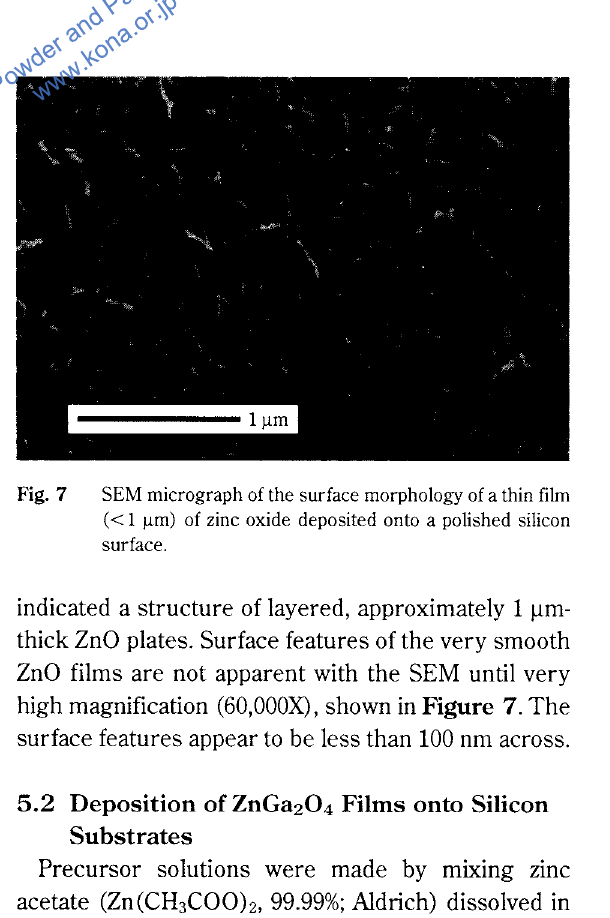
deposited at 350°C, annealed at 700°C for 3 hours, and annealed at 1000°( for 2 hours.